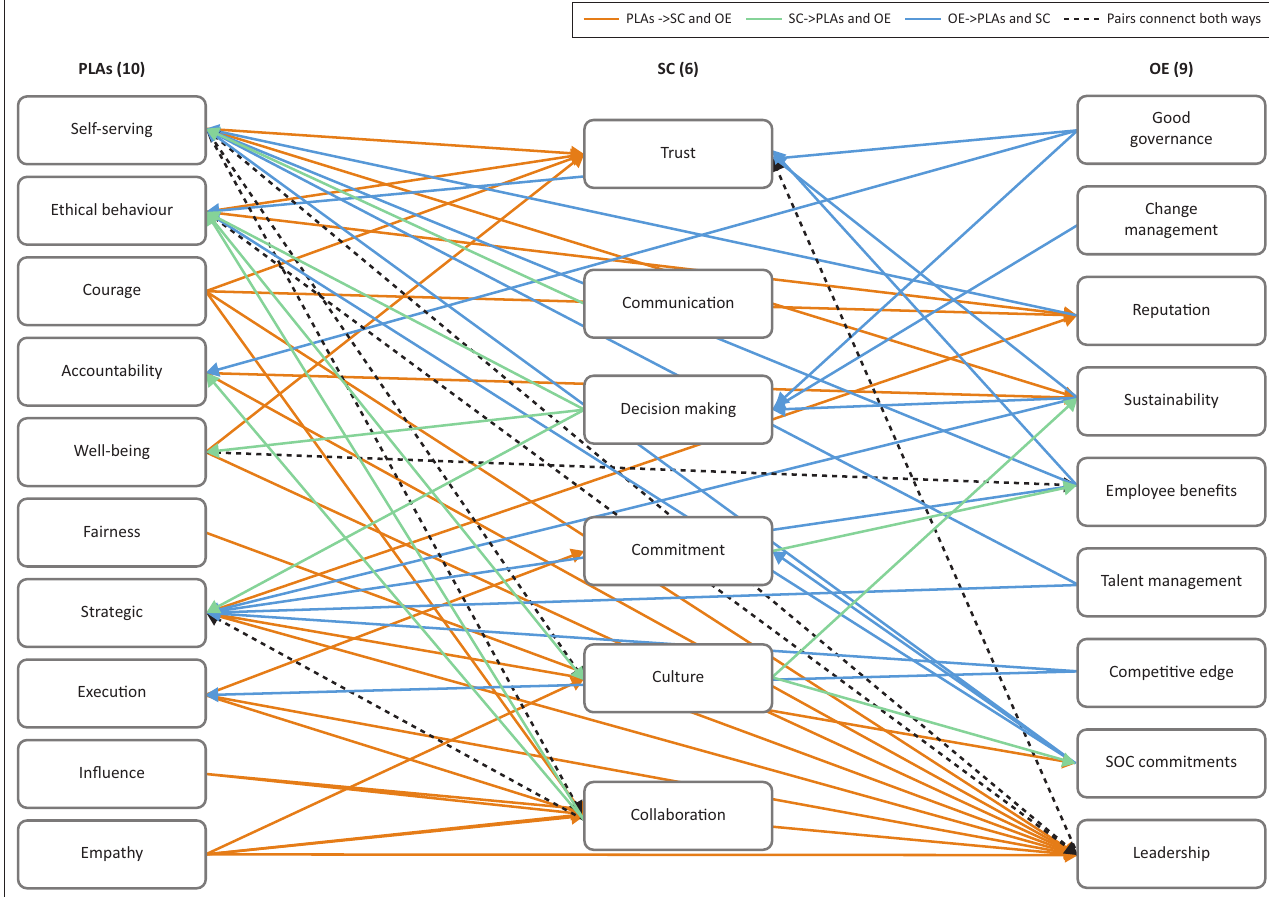
FIGURE 2: Final validated